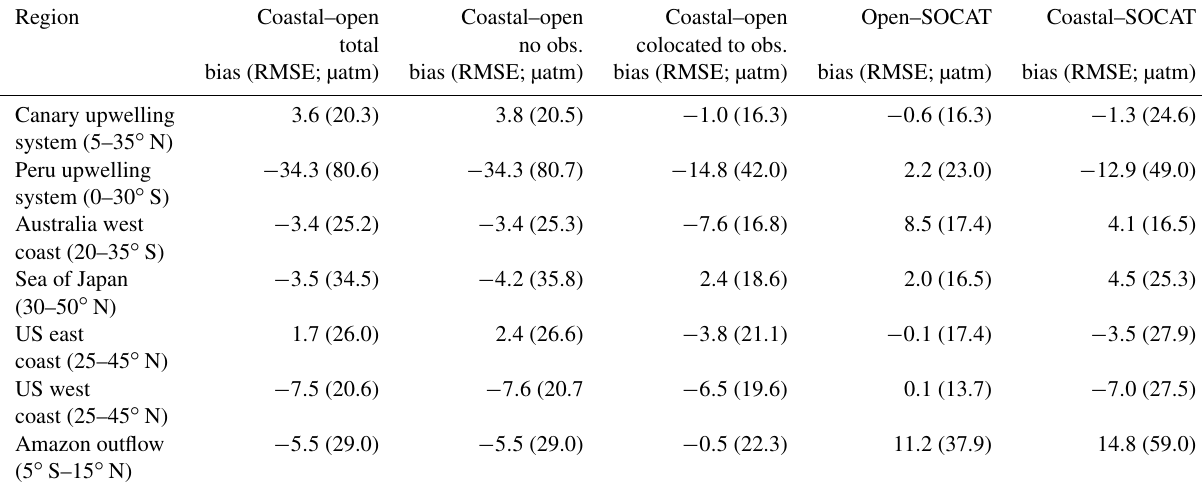
Table 2. Mean error analysis (bias and RMSE) within the overlap area between NN open and NN coast and the observations from the SOCATv5 dataset (Bakker et al., 2016) for 7 oceanic regions. The comparison is performed for the total overlap area, the area fraction where no observations exist and the area covered by observations. The biases and RMSE between p CO 2 products and SOCATv5 datasets are also reported for the open ocean and coastal